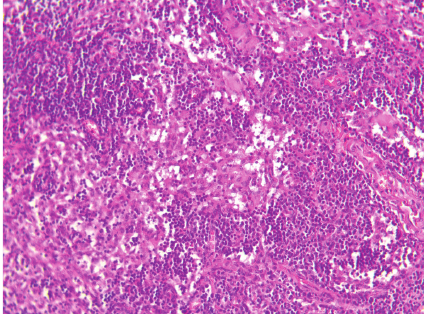
Figure 1: Focal metastatic colonization of the pericystic lymph node.